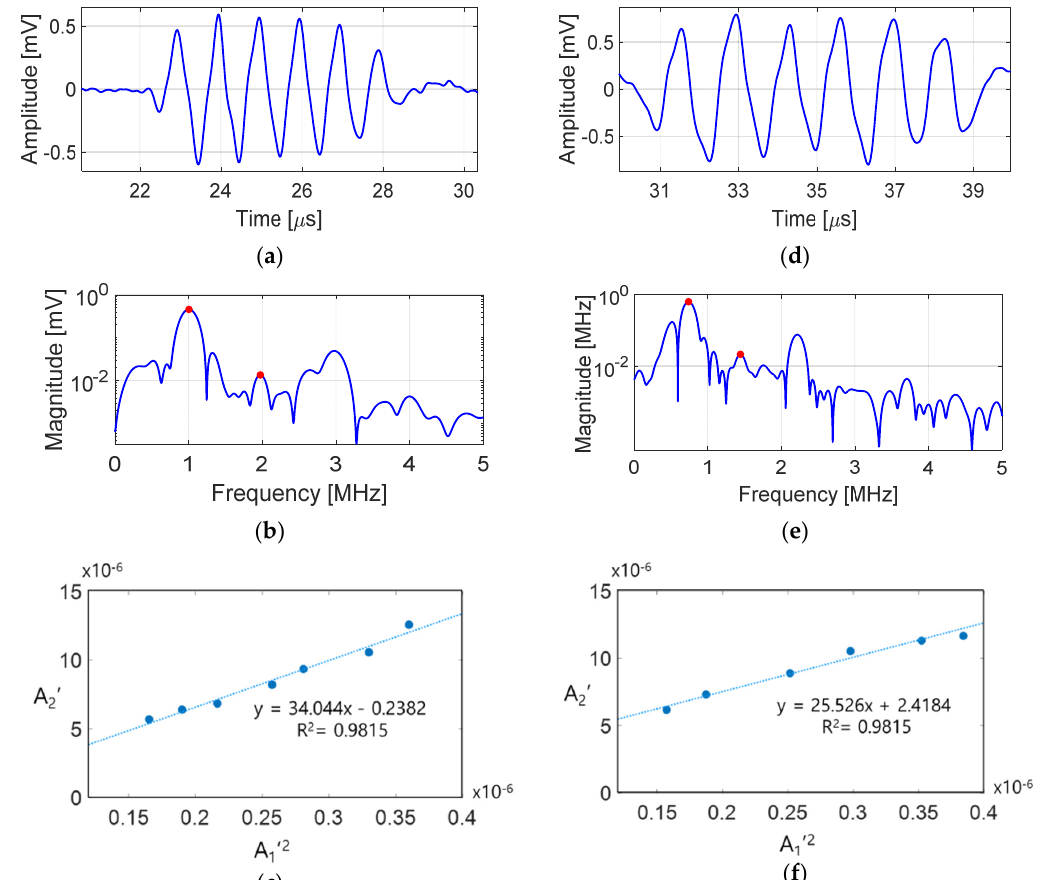
Figure 3. Experimental results: ( a – c ) represent Al2024, and ( d – f ) represent copper. ( a , d ): Raw signals, ( b , e ): frequency spectra of raw signals, ( c , f ): linear fitting of A 1 ′ 2 and A 2 ′ .